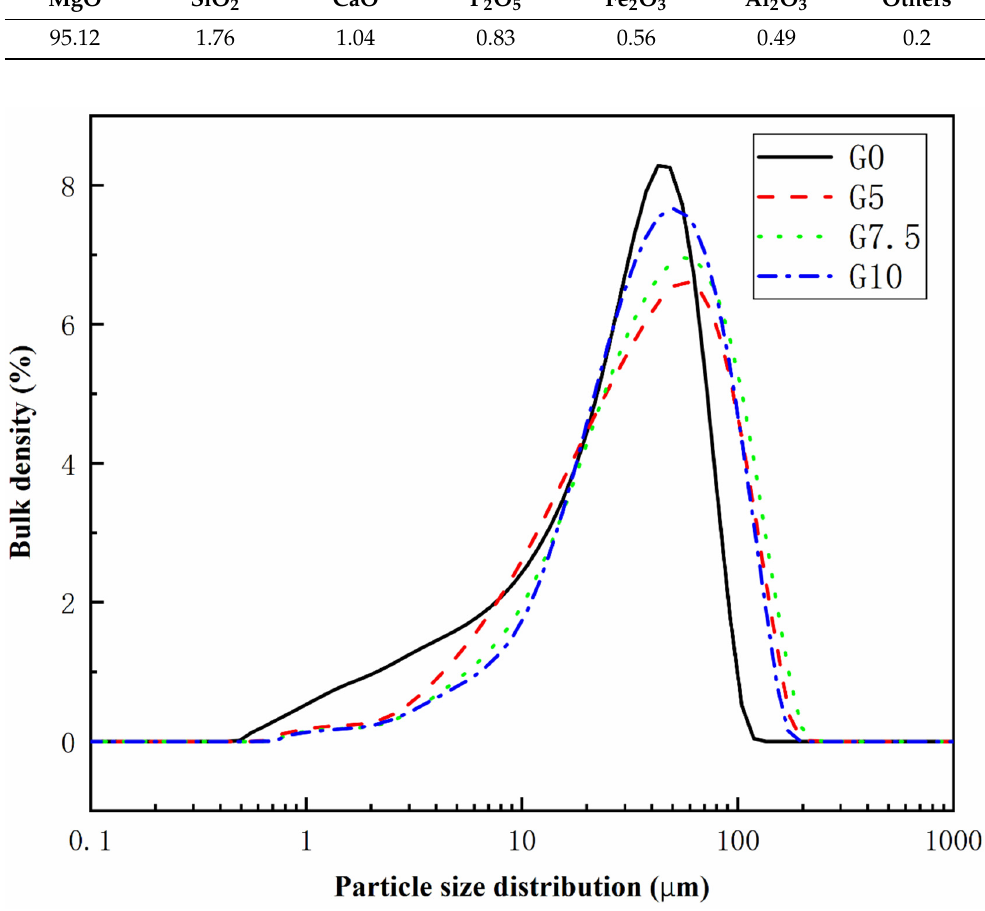
Figure 1. Particle size distribution of different modified MgO. Sodium water glass (Na 2 O·nSiO 2 ) is a translucent liquid, with a modulus of 2.8, sup- plied by Xinjie Chemical Co., Ltd, Mianyang, China. Potassium dihydrogen phosphate (KH 2 PO 4 , KDP, P for abbreviation) and borax (Na 2 B 5 O 7 ·10H 2 O, B for abbreviation) are in- dustrially pure products both with a purity of 99.0%. Experimental water used was a mix- ture of ice and water to ensure the water temperature was 0 °C.